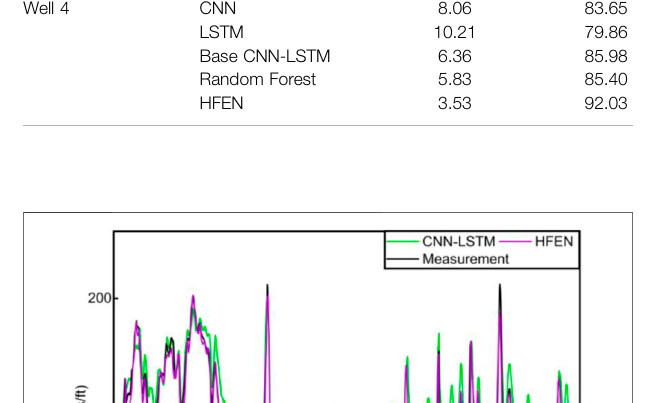
FIGURE 12 | HFEN vs. Measurement in well 2.